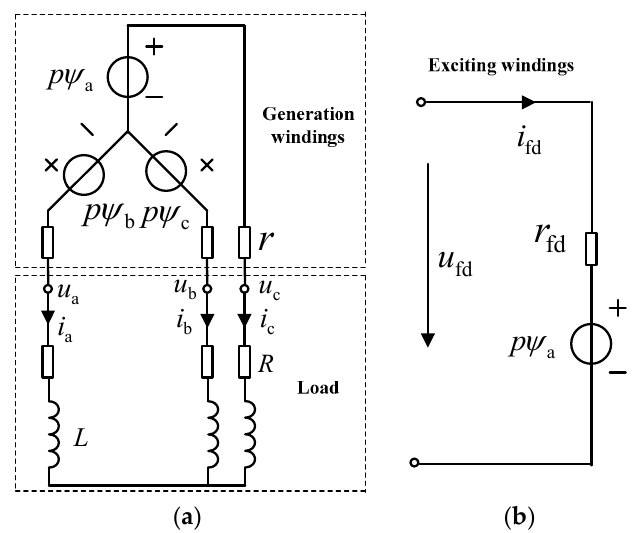
Figure 5. The equivalent circuit of HEBPMG ( a ) The equivalent circuit of power generation; ( b ) The equivalent circuit of excitation.